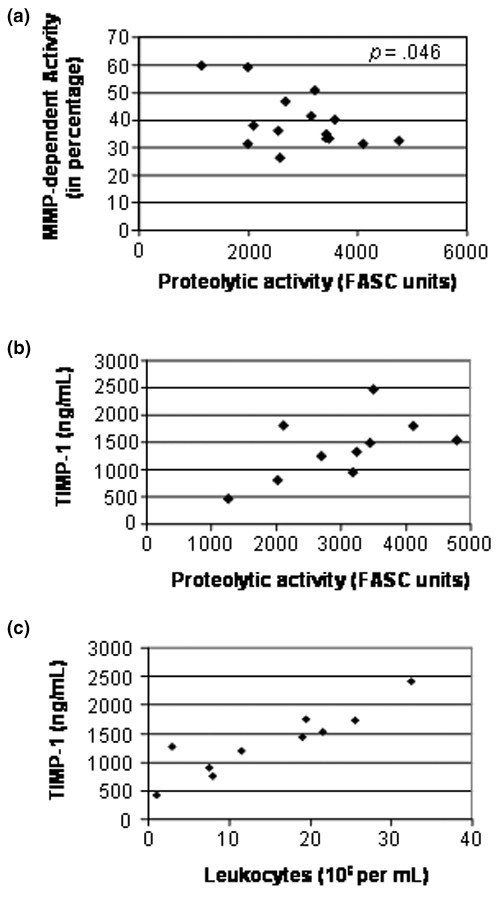
Levels of TIMP-1 in synovial fluid of rheumatoid arthritis patients. (a) Inverse correlation between the matrix metalloproteinase (MMP)-dependent proteolytic activity and the level of proteolytic activity in synovial fluids of rheumatoid arthritis (RA) patients (r = -0.521, P = 0.046). (b) Correlation between the level of TIMP-1 and the net proteolytic activity (r = 0.592, P = 0.07). (c) Positive correlation between the level of TIMP-1 and the number of infiltrated leukocytes (r = 0.910, P < 0.001). The levels of TIMP-1 in synovial fluids were measured by commercial ELISA. The contribution of MMPs to the proteolytic activity was carried out using the hydroxamate inhibitor II, as described in Figure 4. Each point represents one sample. The correlation was calculated using Spearman's rank correlation coefficient for each test. FASC, fluorescent-activated substrate conversion.